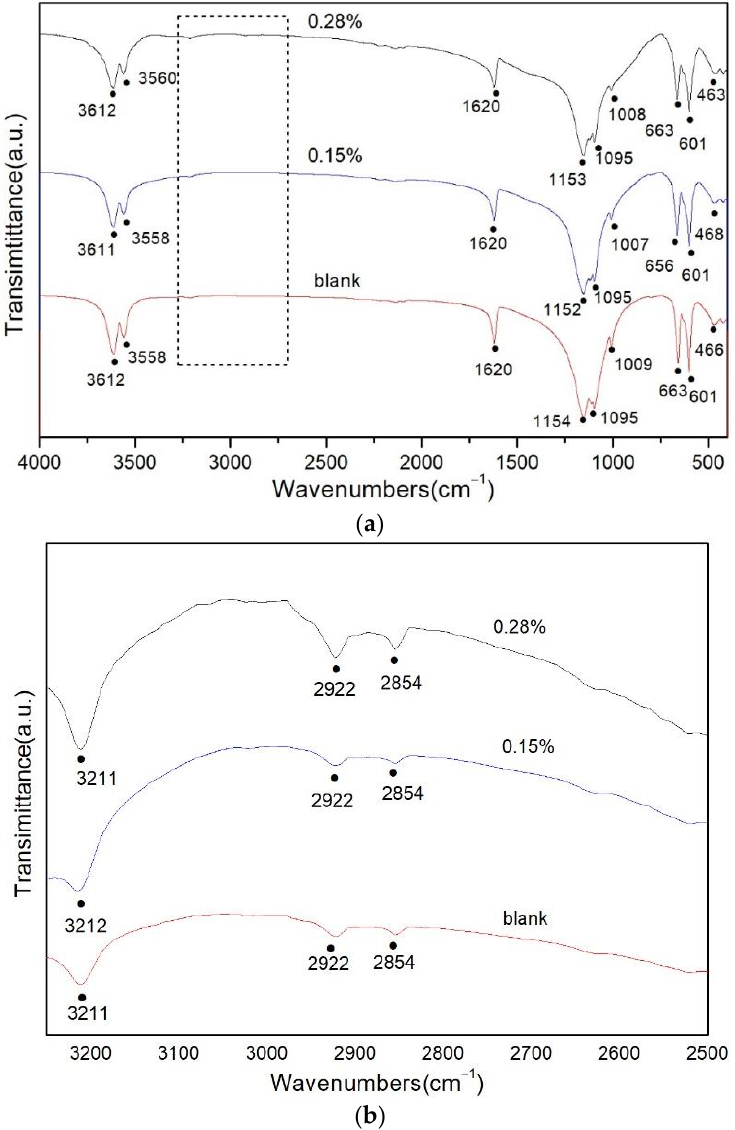
Figure 6. FTIR spectra of ( a ) samples obtained from different dosage of potassium sodium tartrate; ( b ) magnified picture (from 2500 cm −1 to 3250 cm −1 as the part of the dashed box in ( a )).